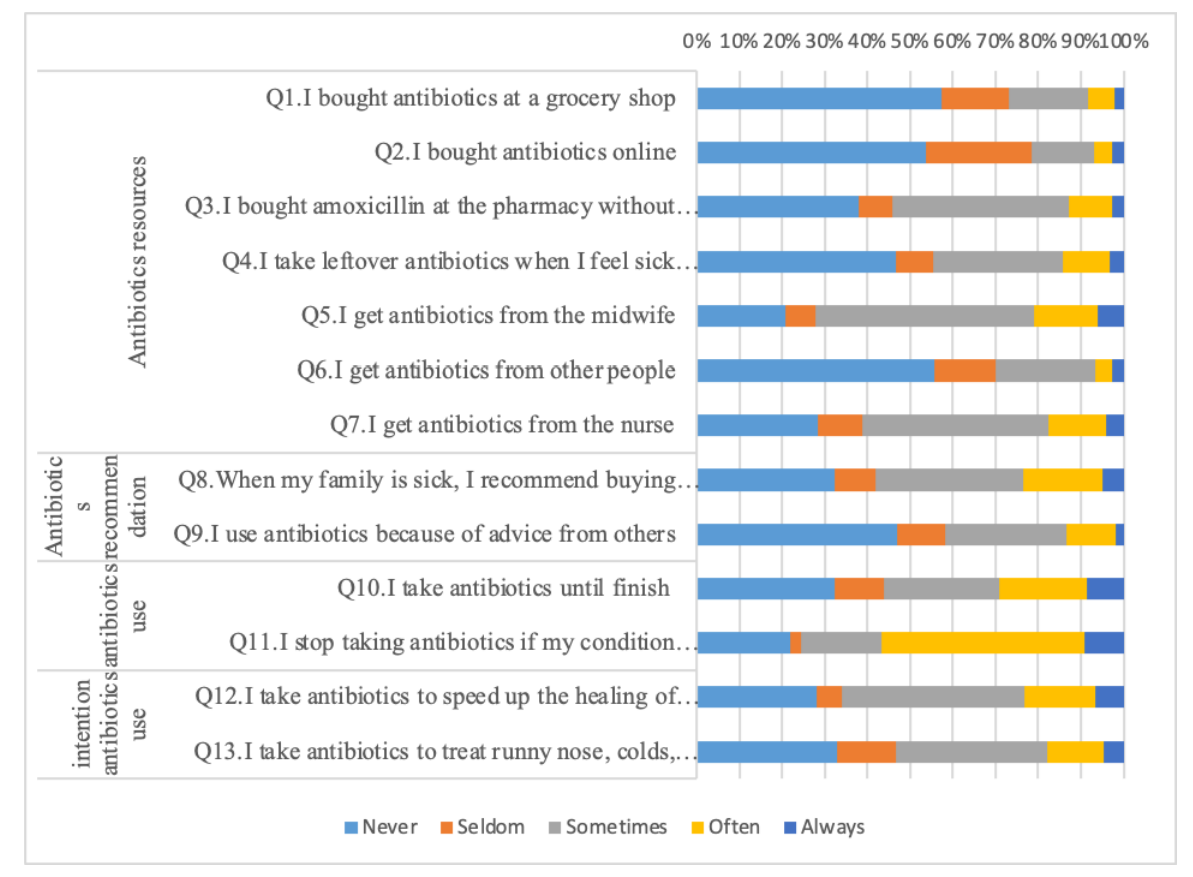
Figure 3. The response profile of antibiotics practices among the people. Data presented here is question-specific and not compared with any demographic characteristic.